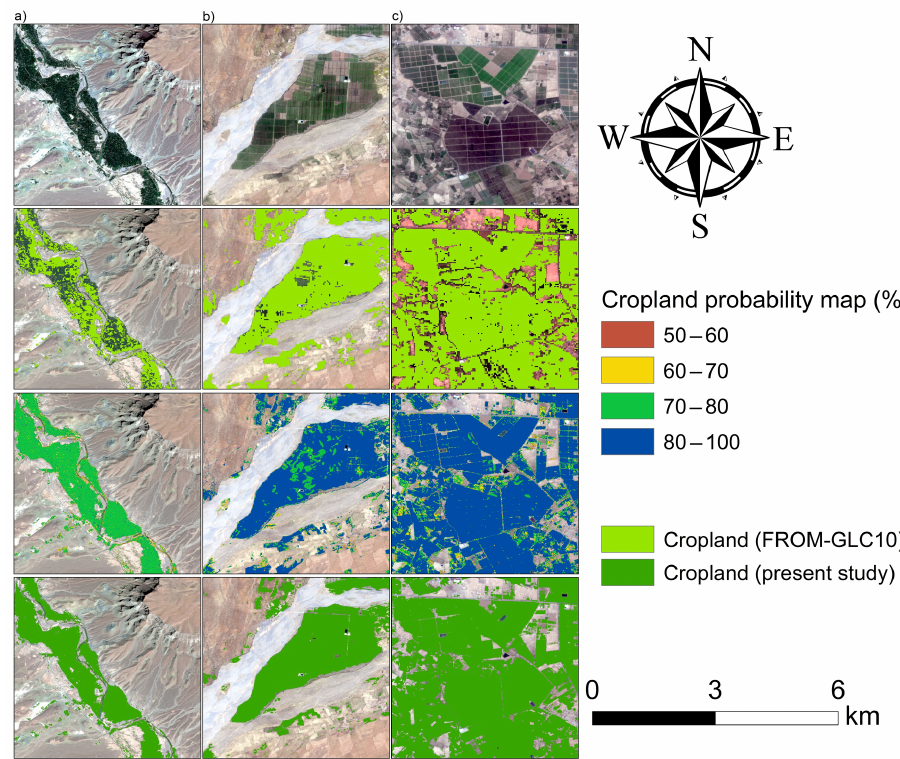
Figure 14. Zoom-in view of the probability maps of cropland areas, cropland classification of the present study, cropland cover maps of FROM-GLC10, and its comparison with RGB composite of Sentinel-2 cloud-filtered images for the same period (2016–2017 season) in the three locations ( a – c ) highlighted in Figure 13.